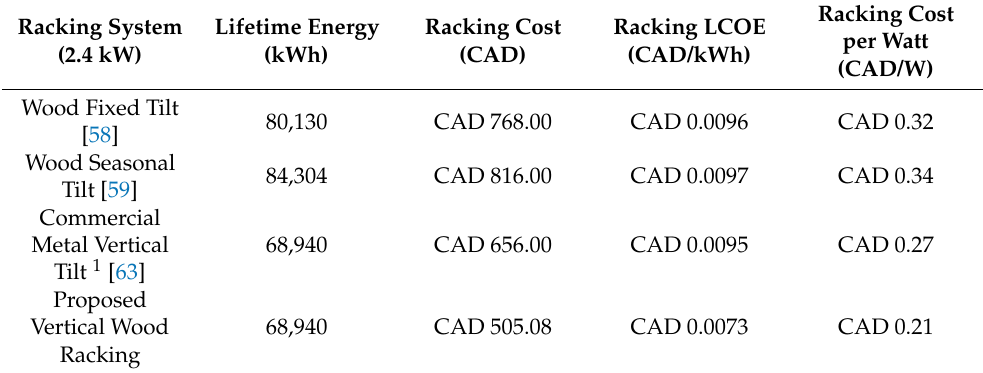
Table 3. Cost comparison of the proposed racking system and a commercial racking